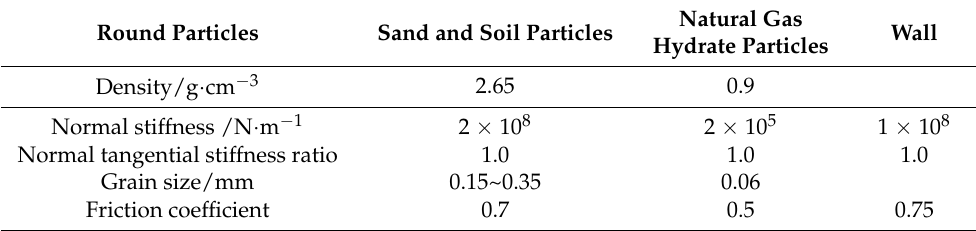
Figure 8. Comparison of discrete element simulation and experimental results of shear test of natural gas hydrate deposits. (Adapted with permission from Ref. [37]. 2021, Wu, D.J). Table 1. Characteristic parameters of sand, hydrate particles, and walls in the model.